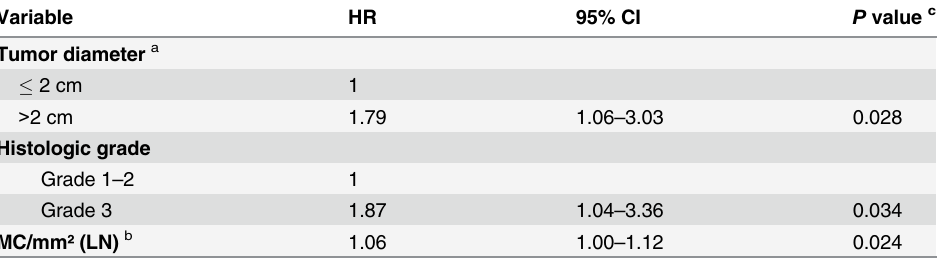
Table 5. Multivariate survival analysis (Cox`s proportional hazards method) Final model after initial inclusion of tumor diameter, histologic grade, Ki-67 in PT b , Ki-67 in LN b , MC in PT b , MC in LN b ( n = 168). Variable HR 95% CI P value